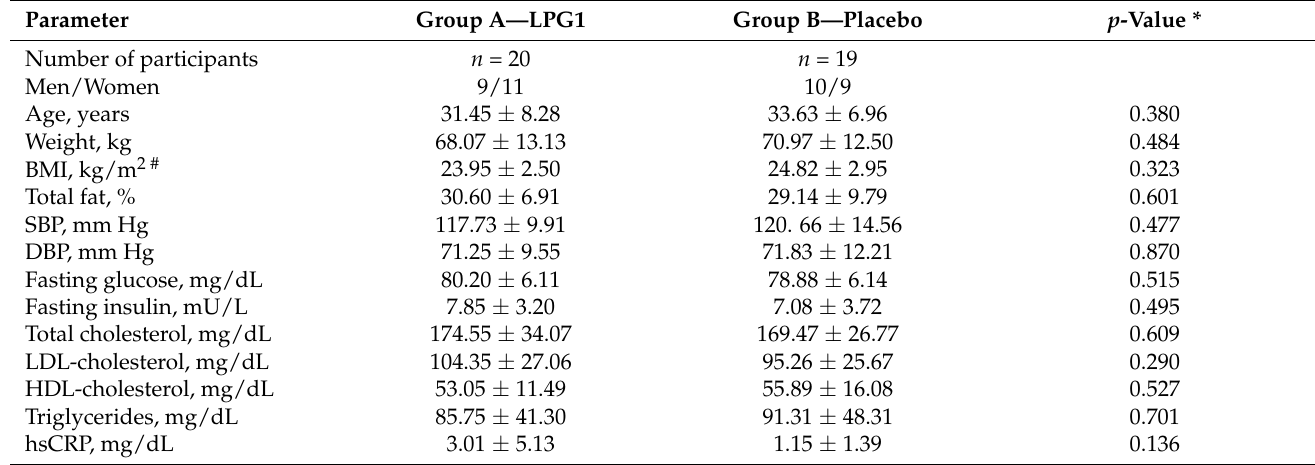
Table 1. Baseline information of the groups included in the randomised, placebo-controlled, single- blind trial to study the effect of oral intake of L. pentosus LPG1 on the human gut microbiota. The data includes participants’ characterisation, the average baseline for their clinical parameters, metabolic and lipid profiles of the volunteers, and a statistical comparison between A-LPG1 and B-placebo groups. The p -values did not show any significant differences between